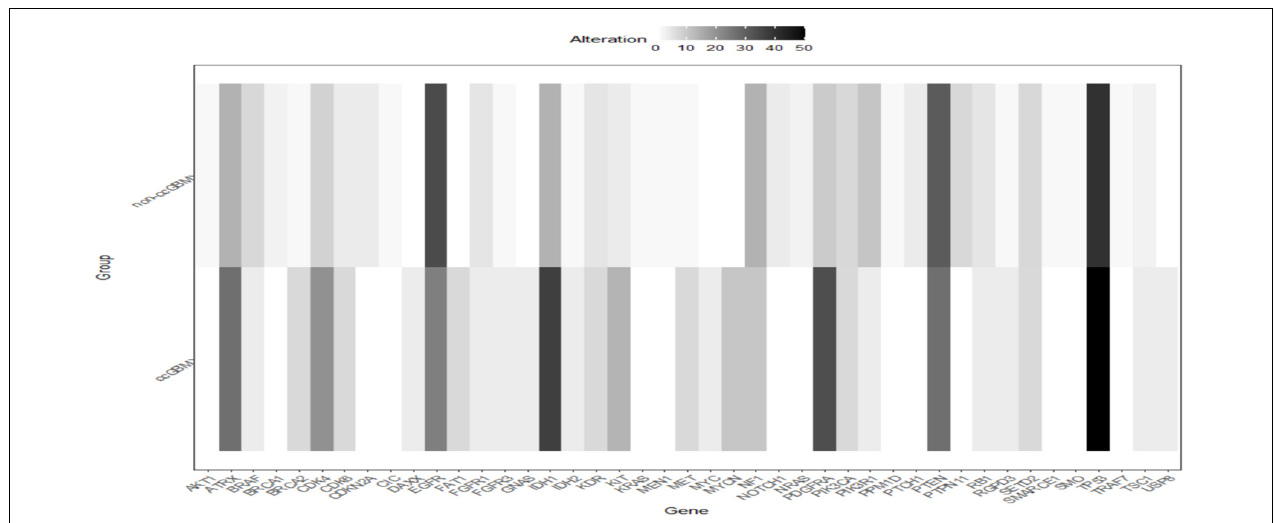
FIGURE 1 | Heatmap of incidences of molecular alterations between ccGBM and non-ccGBM. The horizontal axis represented different genes, the longitudinal axis represented the two groups of ccGBM and non-ccGBM. Low incidences of alterations were shown in white, high incidences in black.